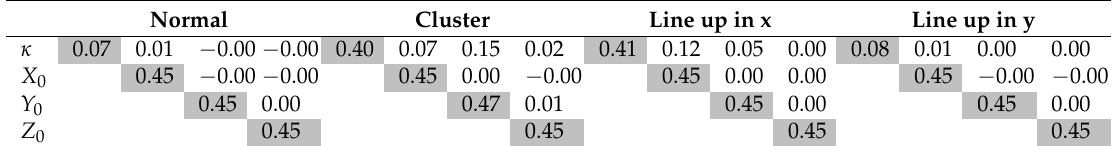
of 4-feature simulated geometries. P ˆ P